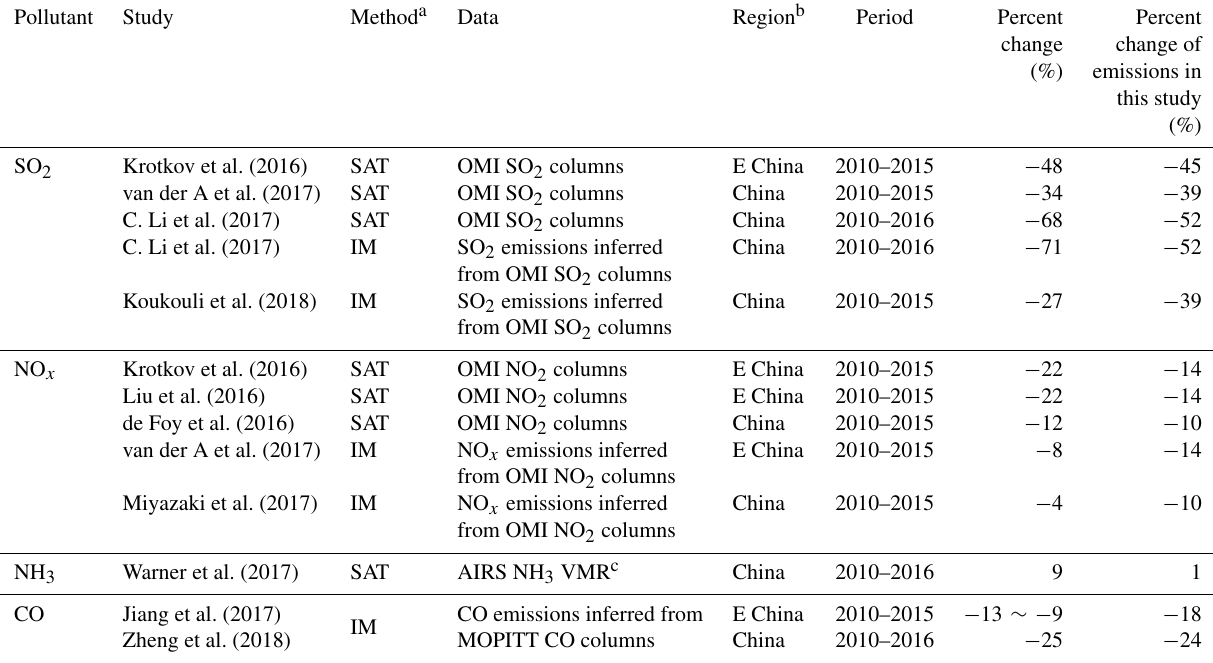
Table 2. Comparison of trends in bottom-up emission inventory, satellite-based observations, and top-down emission estimates since